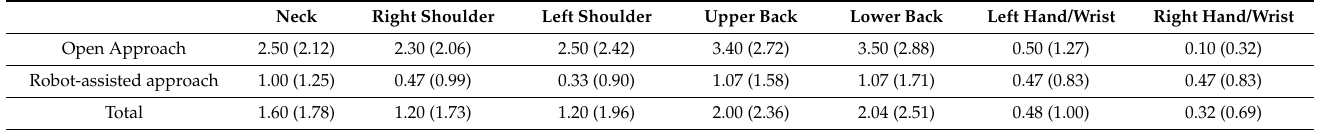
Table 4. Means and standard deviations (in parentheses) for delta